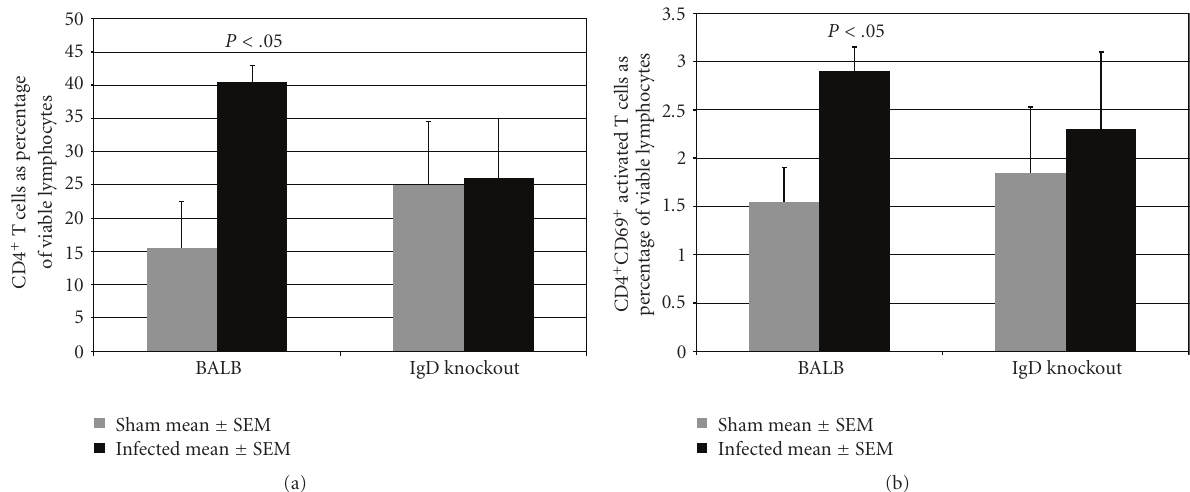
Figure 4: P. gingivalis- infection increased the proportion of CD4 + T cells and activated them in immune normal BALB/cJ mice but not in IgD deficient mice . (a) Total CD4 + T cell population: in immune normal BALB/cJ mice the percentage of total viable CD4 + T cells were higher in infected than in sham-infected ( P < . 05) but in IgD deficient mice the percentage was unchanged by infection ( P > . 05). (b) Activated CD4 + T cells: In BALB/cJ mice the proportion of activated CD4 + CD69 + T cells were higher in P. gingivalis -infected than in sham-infected mice ( P < . 05) but activation was not increased by infection in IgD deficient mice ( P > . 05). n =